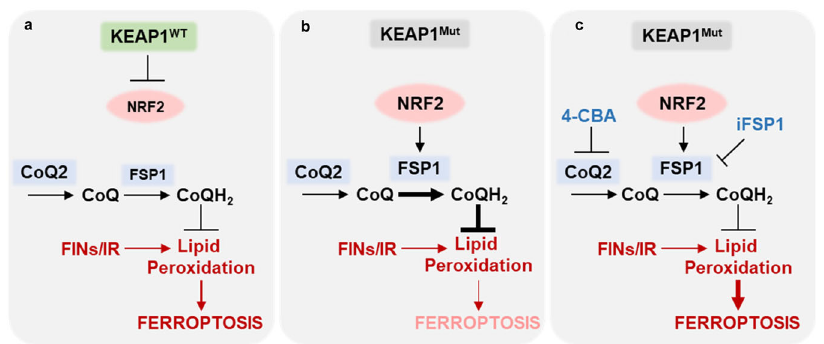
Fig. 7 The working model depicting that FSP1 as an NRF2 transcriptional target is governed by the KEAP1-NRF2 pathway (a, b) and that a targetable CoQ-FSP1 axis drives ferroptosis- and radiation-resistance in KEAP1 inactive lung cancers (b, c). See Discussion for a detailed